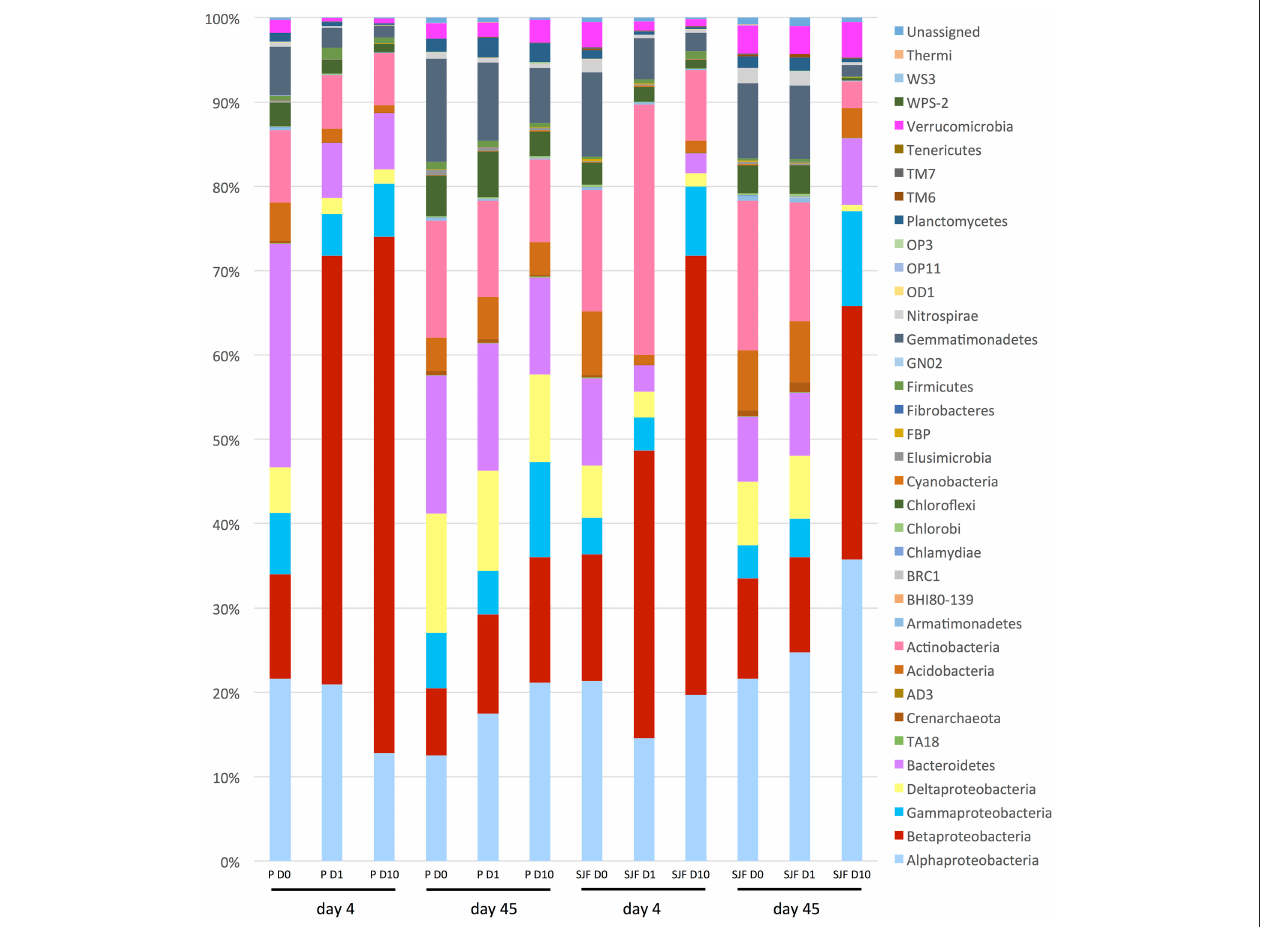
FIGURE 4 | Relative abundance of bacterial phylum and Proteobacteria classes (expressed as % of the total number of OTUs) detected in the P and SJF soils at 4 and 45 days.